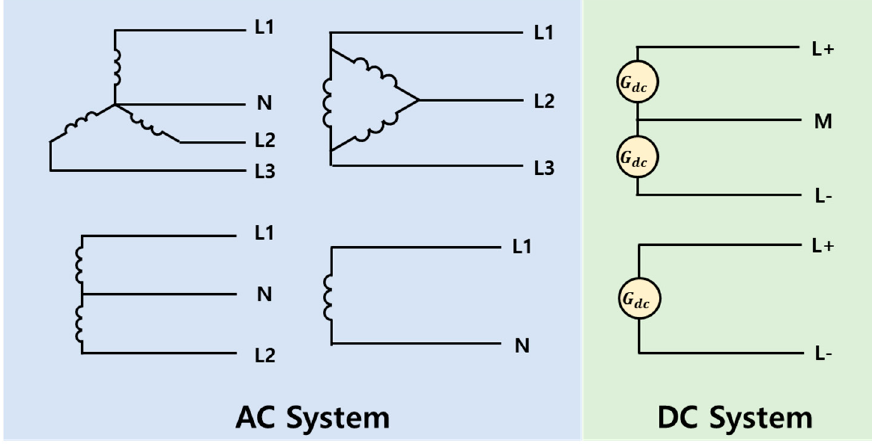
Figure 1. Examples of AC and DC power system classifications based on the phases and wires.